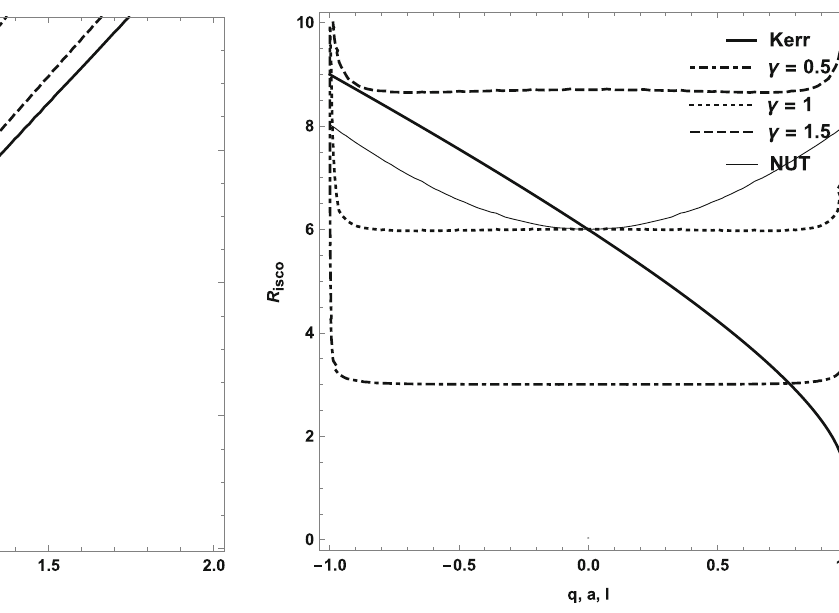
Fig. 4 The dependence of the ISCO radius of test particles on γ and q . Left panel: The ISCO as a function of γ for different values of (cid:2) p = 1 − q 2 . Right panel: The ISCO radius as a function of q for